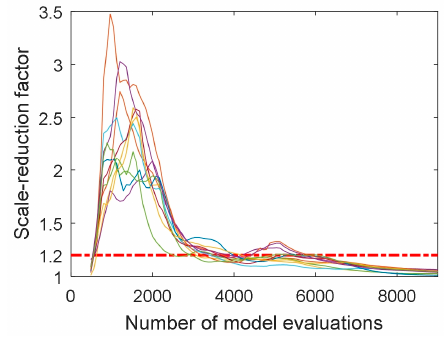
Figure 16. Evolution of the scale reduction factor for the 11 estimation parameters.